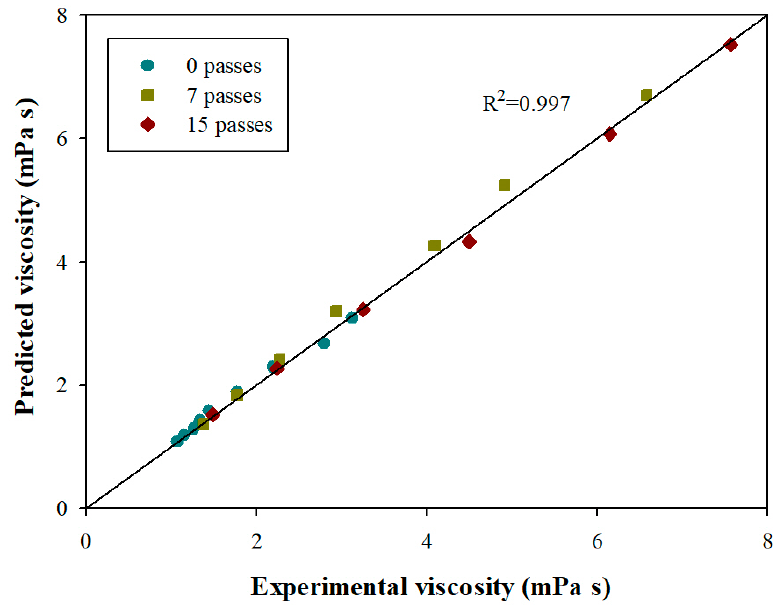
Figure 5. Predicted viscosity versus experimental viscosity of CNF dispersions in the dilute and semi-dilute regions.